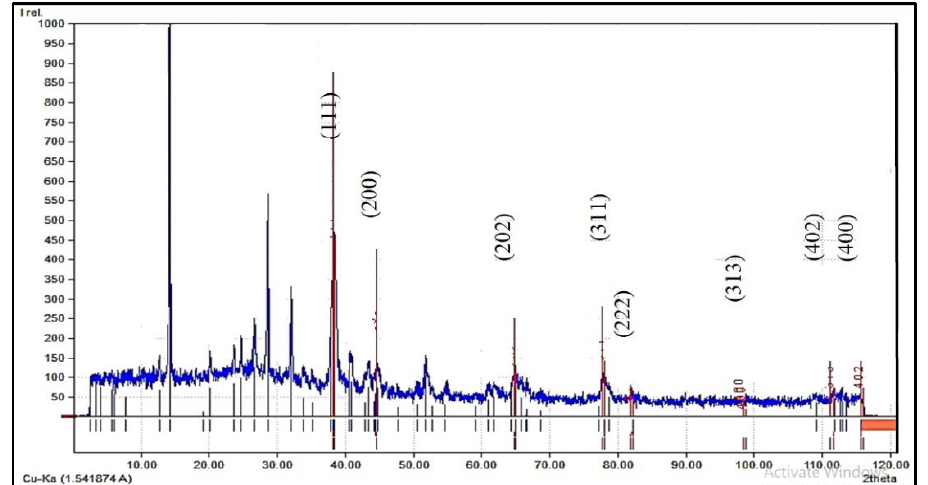
Figure 4: X-ray diffraction pattern of the PSK with gold electrode after one